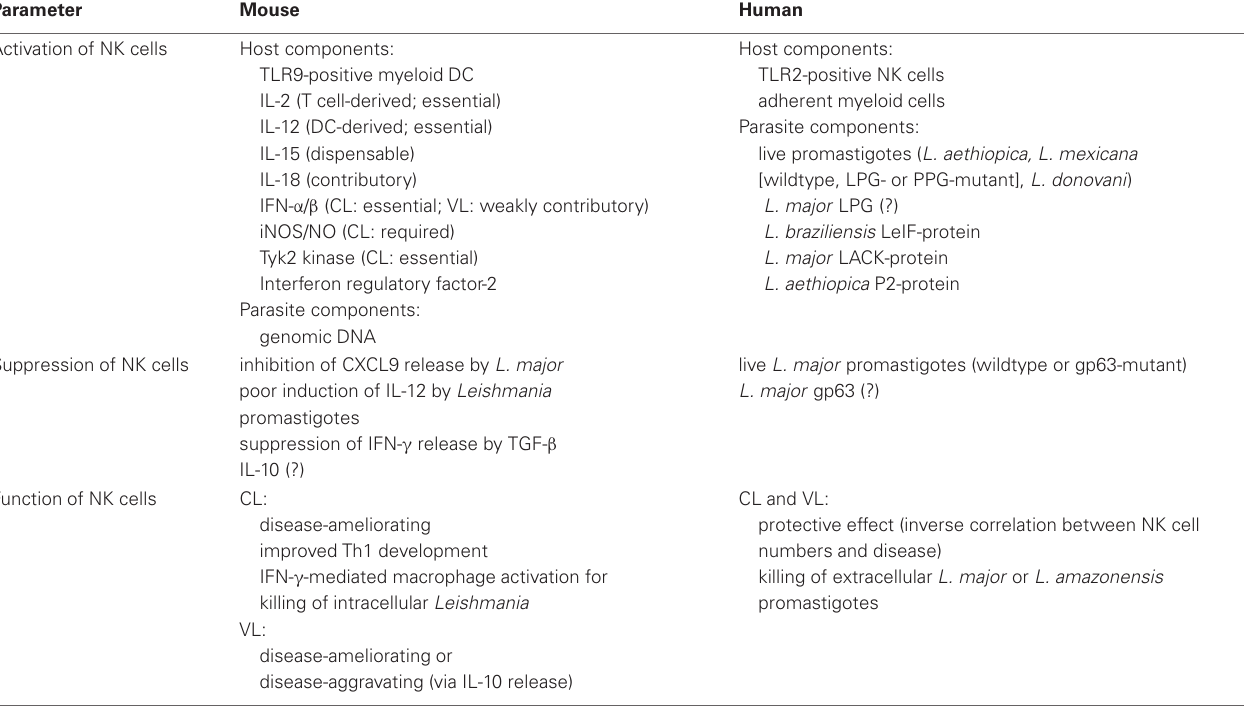
Table 1 | Activation, suppression and function of NK cells in mouse and human cutaneous and visceral leishmaniasis (for references see text). Parameter Mouse Activation of NK